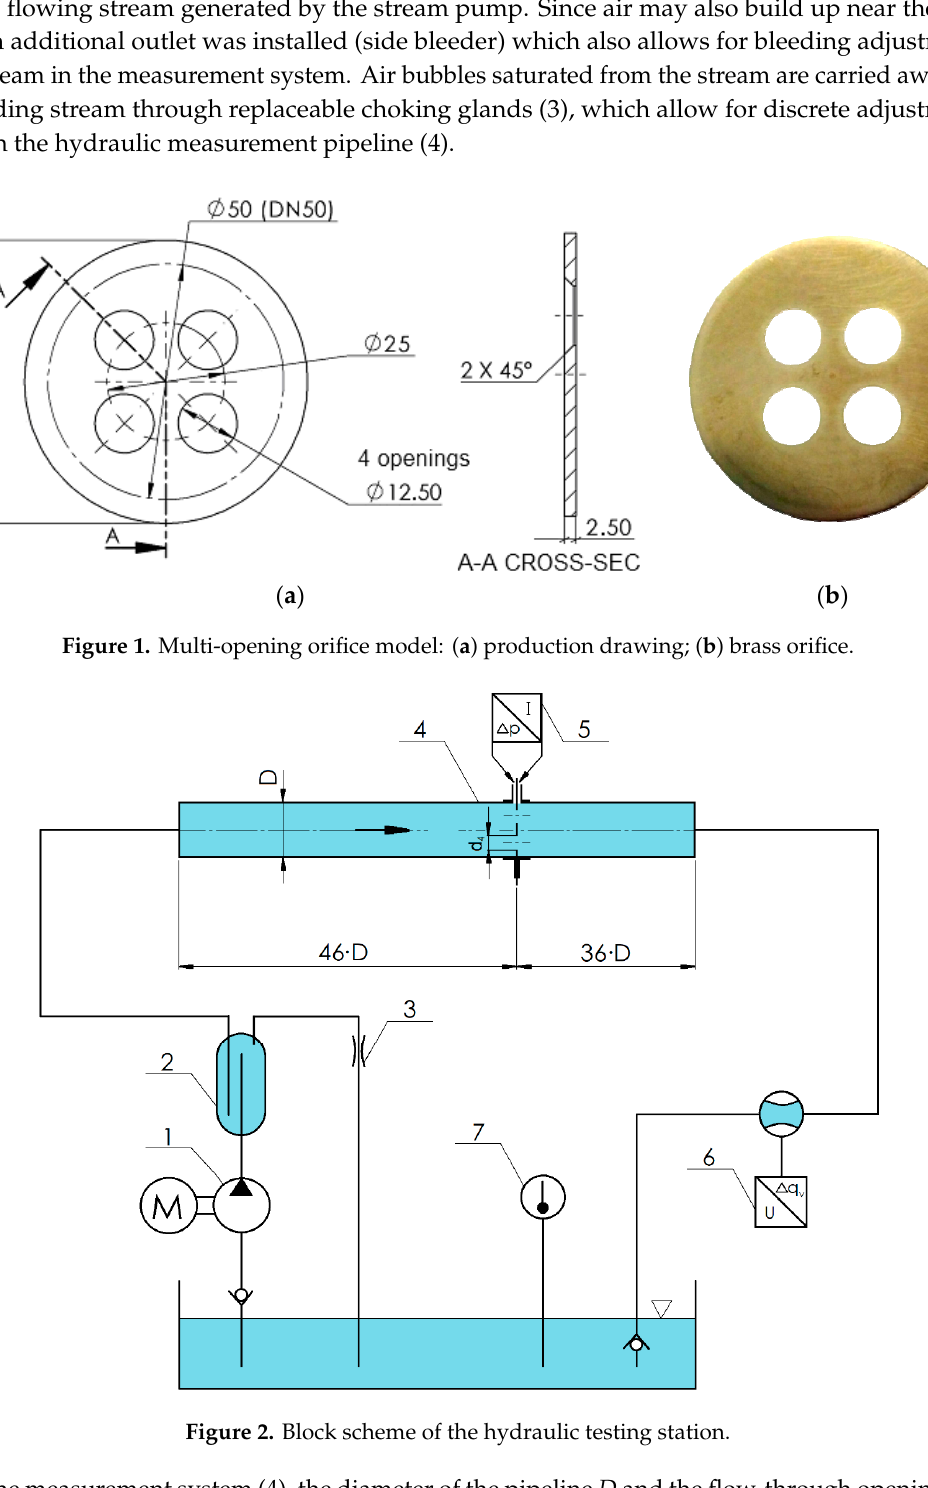
Figure 2. Block scheme of the hydraulic testing station.